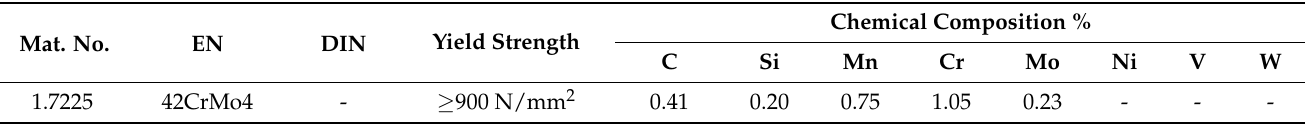
Table 3. Machining parameters.